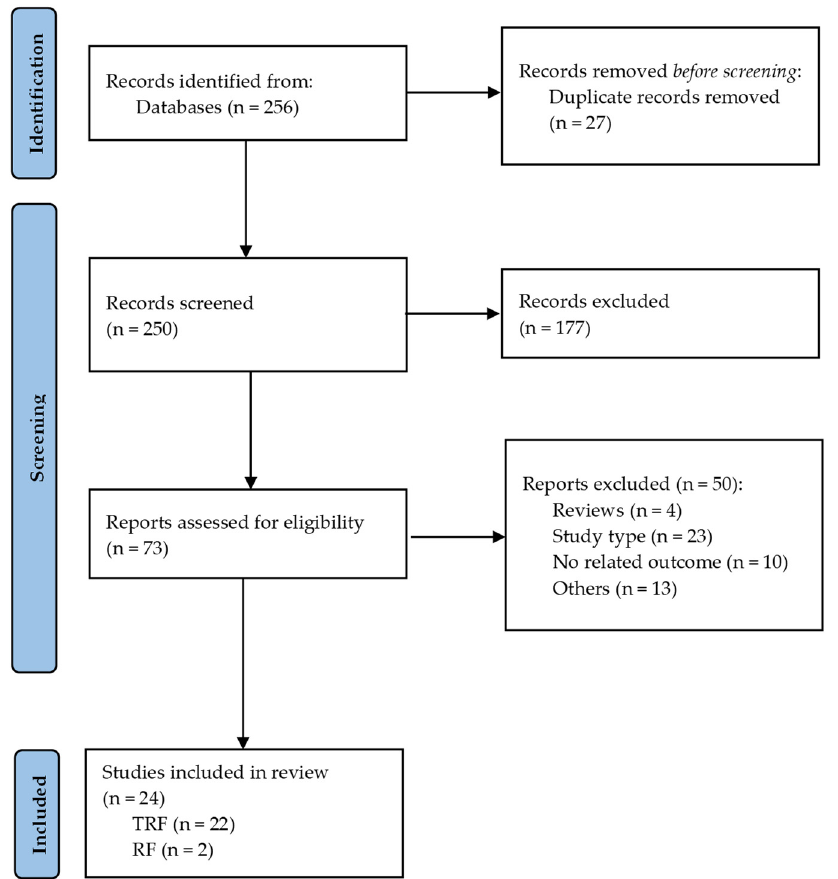
Figure 1. PRISMA flow diagram of included studies.